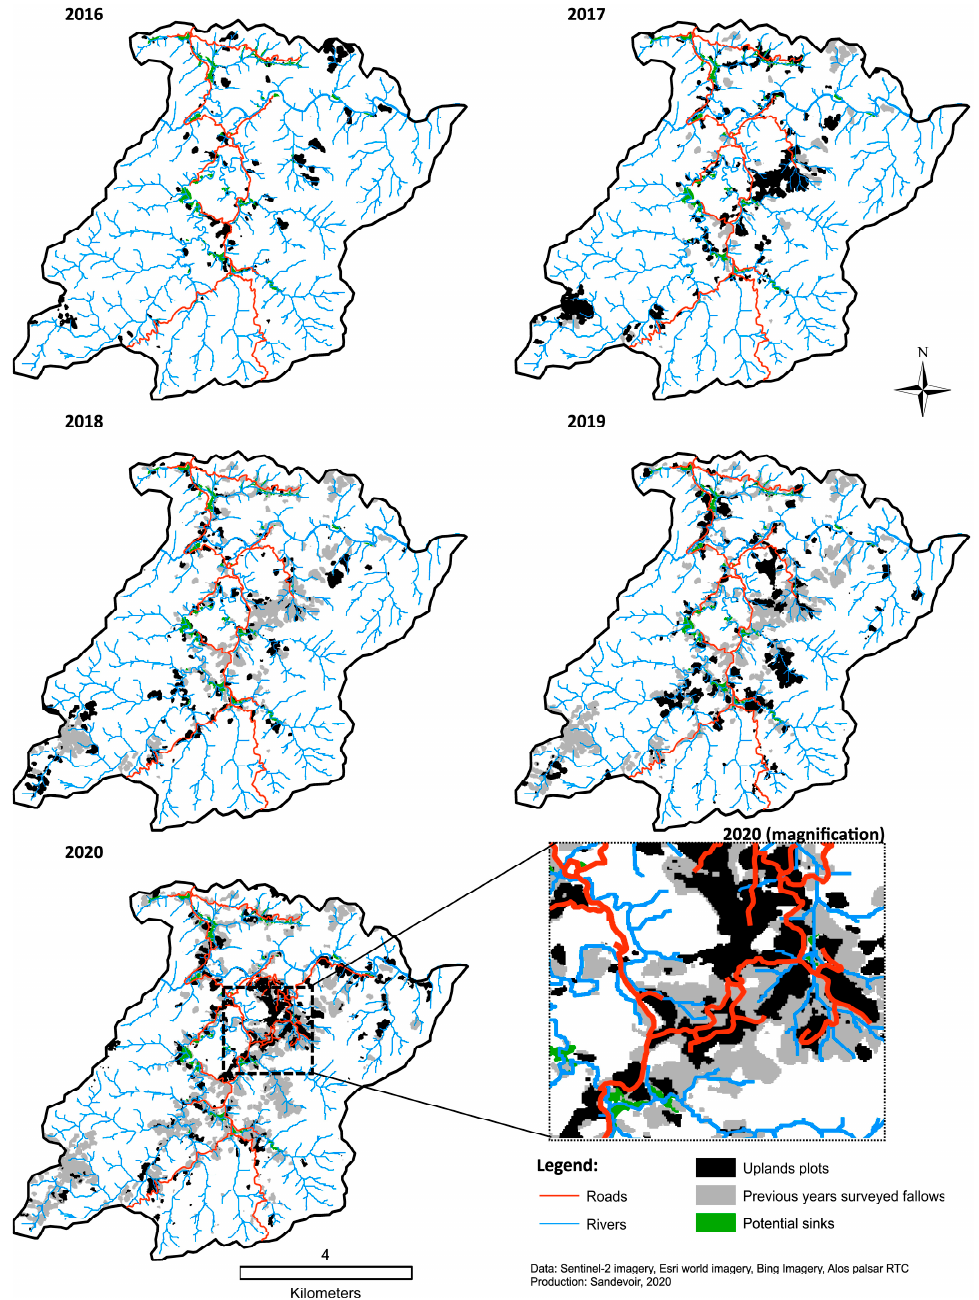
Figure 9. Map showing land use transition from 2016 to 2020. Table 4. Houaylack-Vangven shifting cultivation extension, 2016–2020. Y